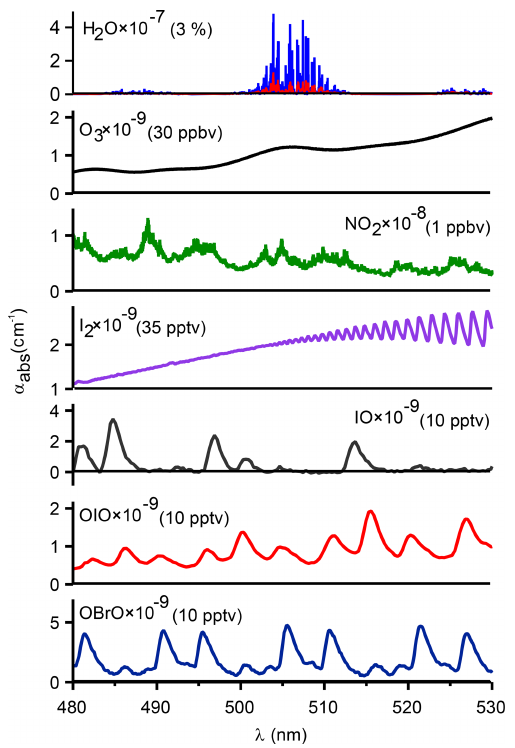
Figure 1. Absorption coefficients for atmospheric absorbers in the cyan region at typical tropospheric mixing ratios (stated in brackets after each species). Absorption cross sections were obtained from Keller-Rudek et al. (2013) and are based on the following: H 2 O (Coheur et al., 2002), O 3 (Burkholder and Talukdar, 1994), NO 2 (Voigt et al., 2002), I 2 (Spietz et al., 2006), IO and OIO (Spietz et al., 2005), and OBrO (Knight et al., 2000). The literature cross sec- tions for H 2 O (shown in blue) were convolved with the resolution of the IBBCEAS (shown in red). The absorption cross section of O 4 is shown in Fig. S4 in the